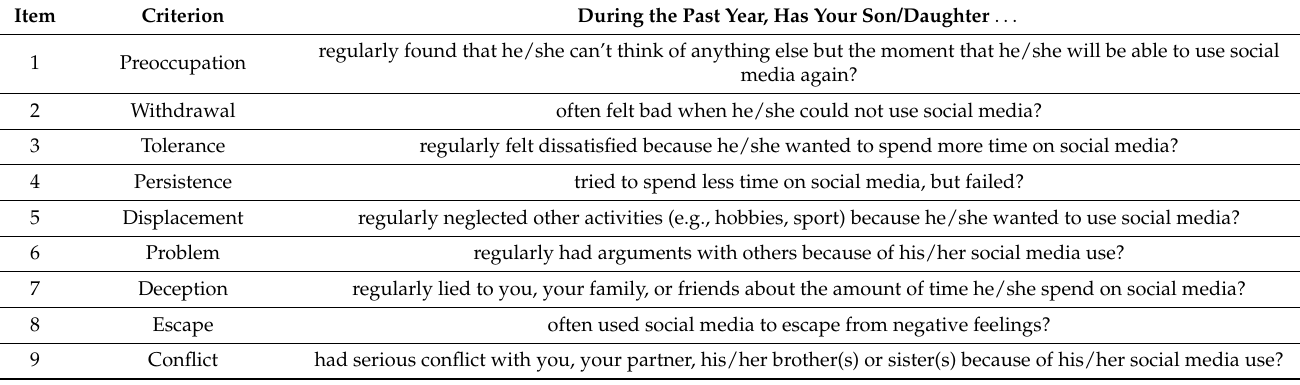
Table 1. The 9-Item Social Media Disorder Scale—Parental Version (SMDS-P) and the corresponding the Diagnostic and Statistical Manual of Mental Disorders (DSM-5)